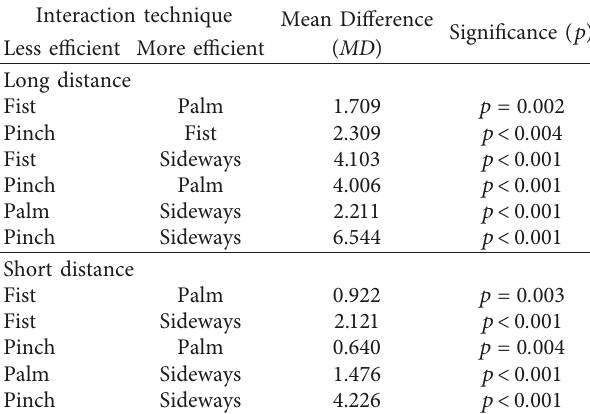
Table 5: Bonferroni corrected post hoc pairwise comparisons of TRE for all interaction techniques.